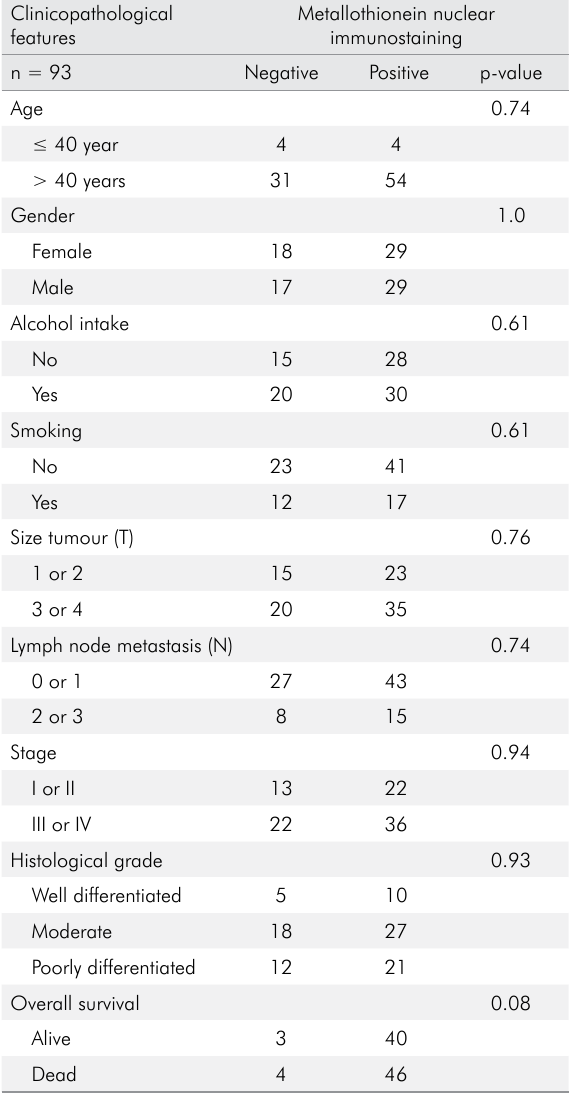
Table. Association between metallothionein immunostaining and clinicopathological variables.